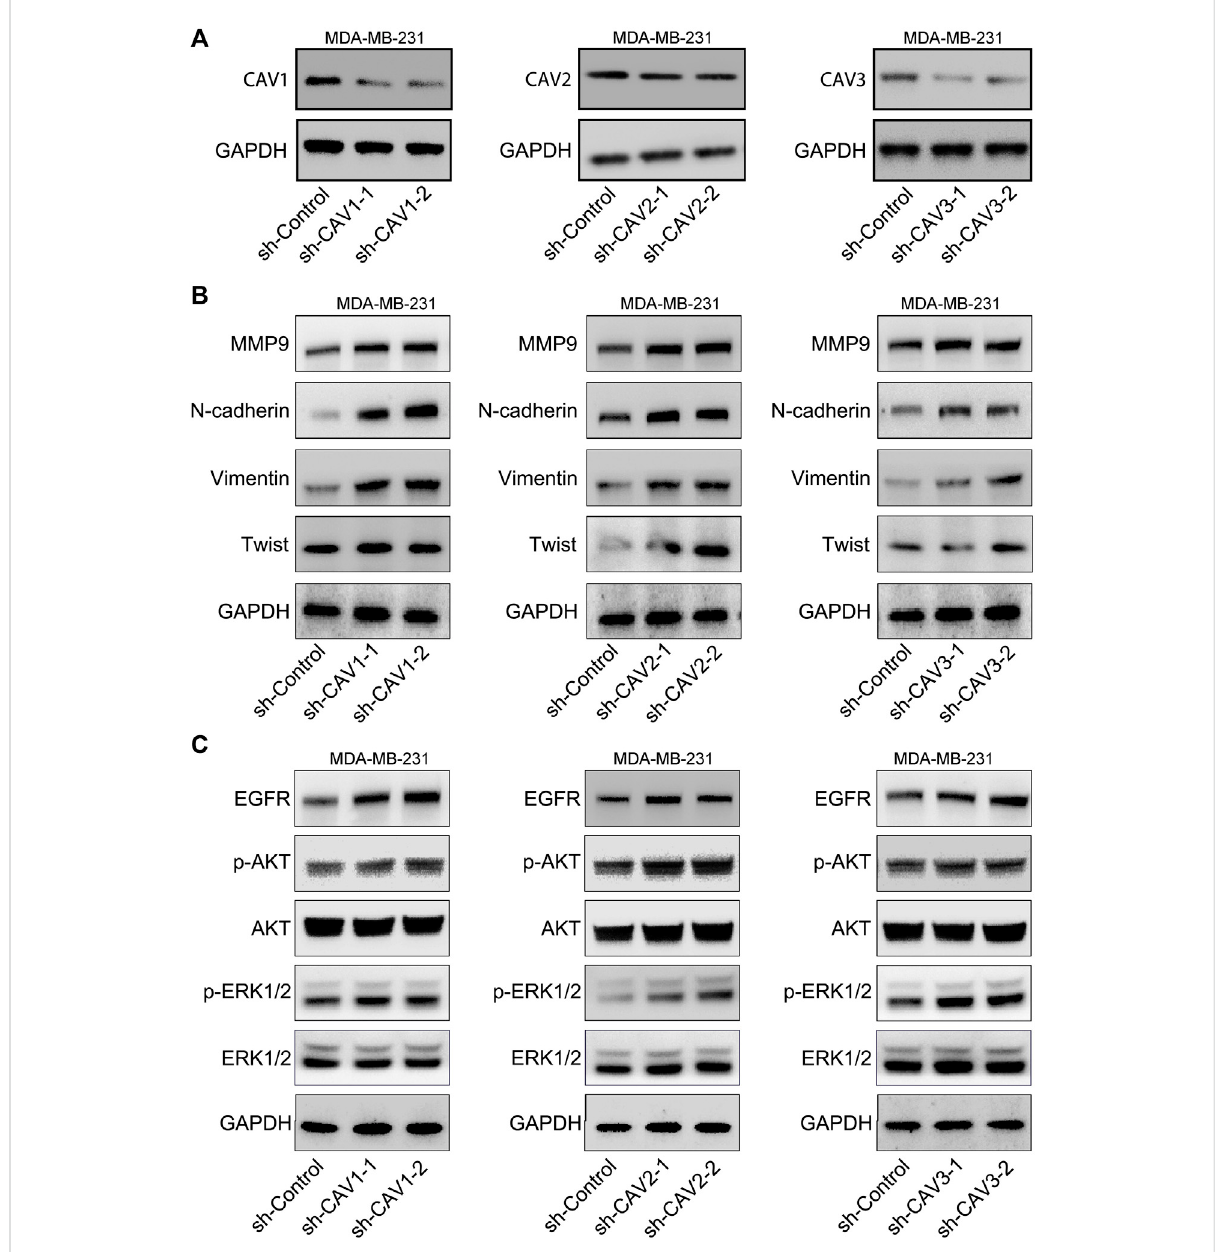
FIGURE 14 CAVs modulated EMT-associated genes and the MAPK and ERK pathways. (A,B) WB analysis detected the expression of Vimentin, N-cadherin, Twist, and MMP9. (C) MAPK and ERK signaling pathway-related proteins were detected using western blotting.